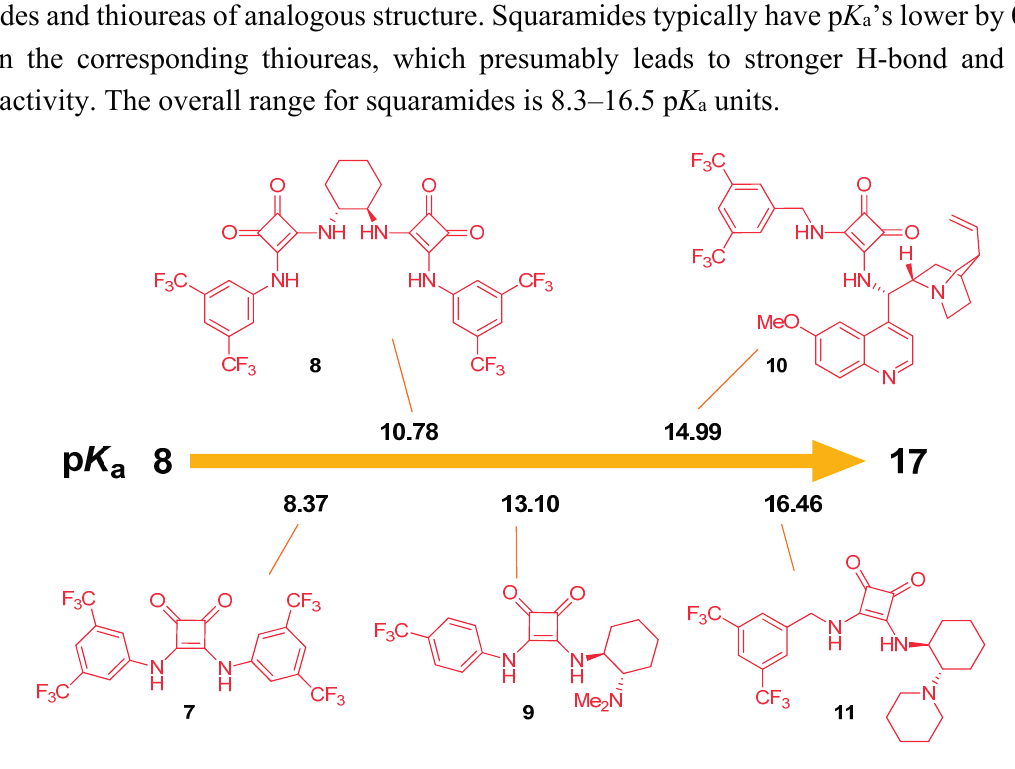
Figure 2. Equilibrium acidities of various squaramides in